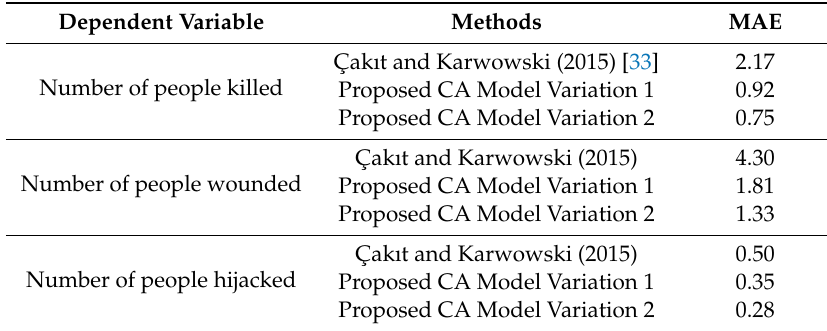
Table 6. Performance comparison of the results for each dependent